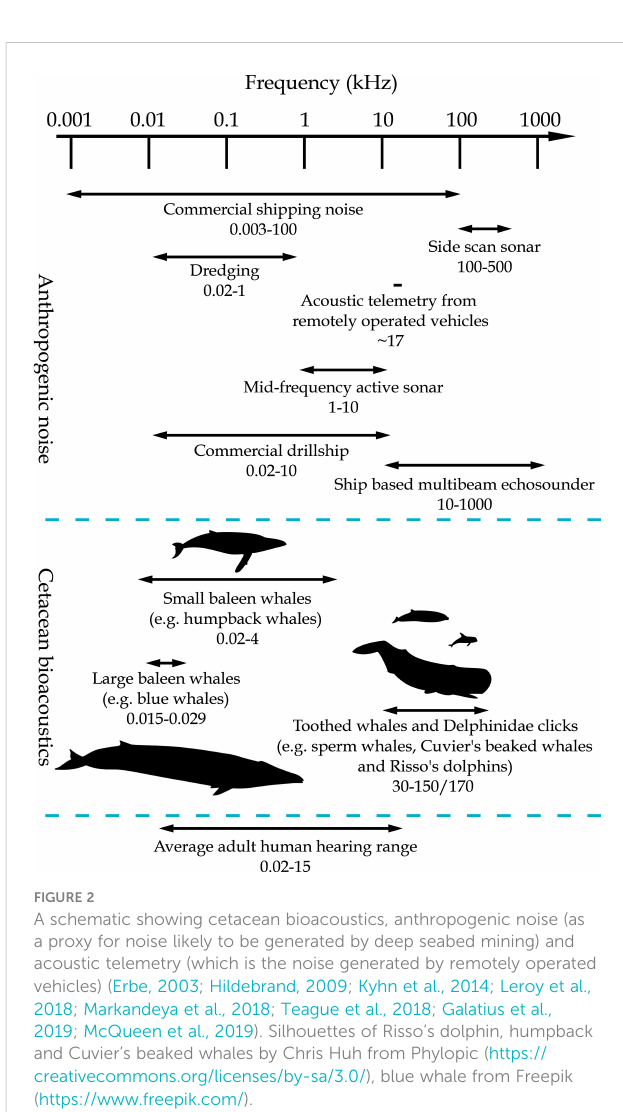
FIGURE 2 A schematic showing cetacean bioacoustics, anthropogenic noise (as a proxy for noise likely to be generated by deep seabed mining) and acoustic telemetry (which is the noise generated by remotely operated vehicles) (Erbe, 2003; Hildebrand, 2009; Kyhn et al., 2014; Leroy et al., 2018; Markandeya et al., 2018; Teague et al., 2018; Galatius et al., 2019; McQueen et al., 2019). Silhouettes of Risso ’ s dolphin, humpback and Cuvier ’ s beaked whales by Chris Huh from Phylopic (https:// creativecommons.org/licenses/by-sa/3.0/), blue whale from Freepik